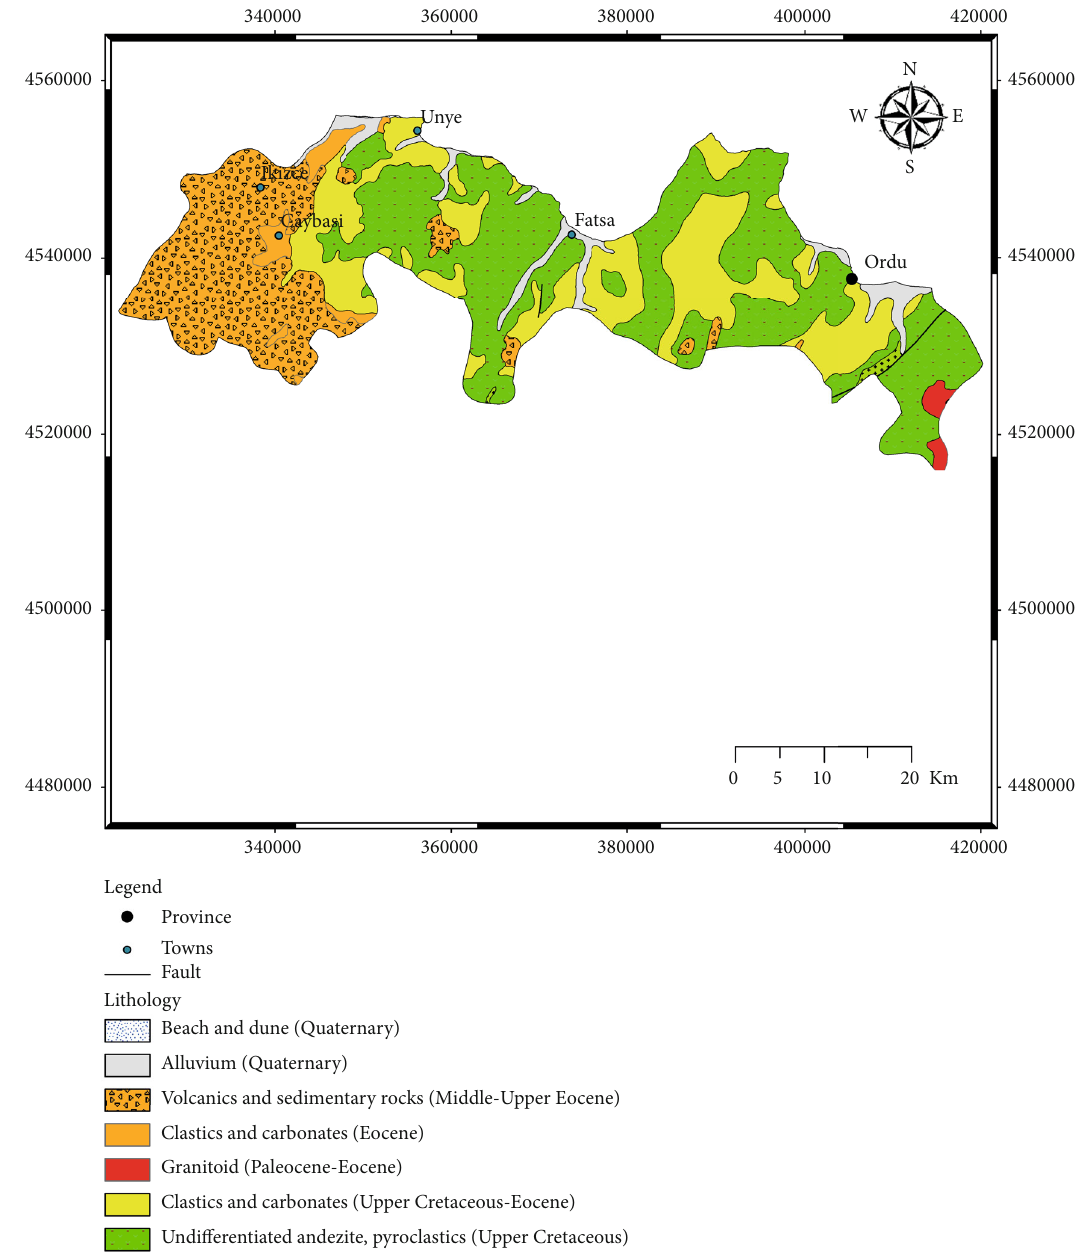
Figure 2: Geological characteristics of the study area